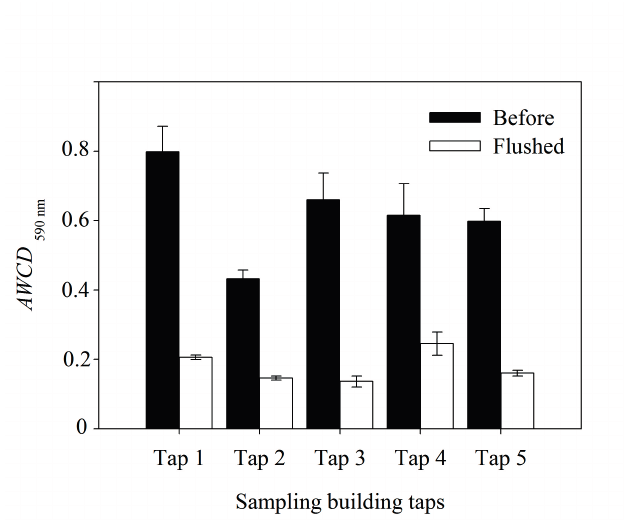
Figure 2. Average Well Color Development ( AWCD 590nm ) of bacterial functional community in the tap water collected from building taps before flushing (“before”) and flushing for 10 min (“flushed”). The data expressed by the mean and standard errors ( n = 3).